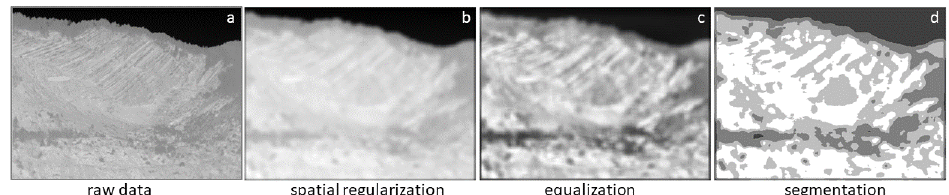
Figure 5. ( a ) Raw TIR image data; ( b ) low-resolution version of panel a; ( c ) output of the his- togram equalization—regions having homogeneous local luminance values are now emphasized; ( d ) segmented image using a choice of four